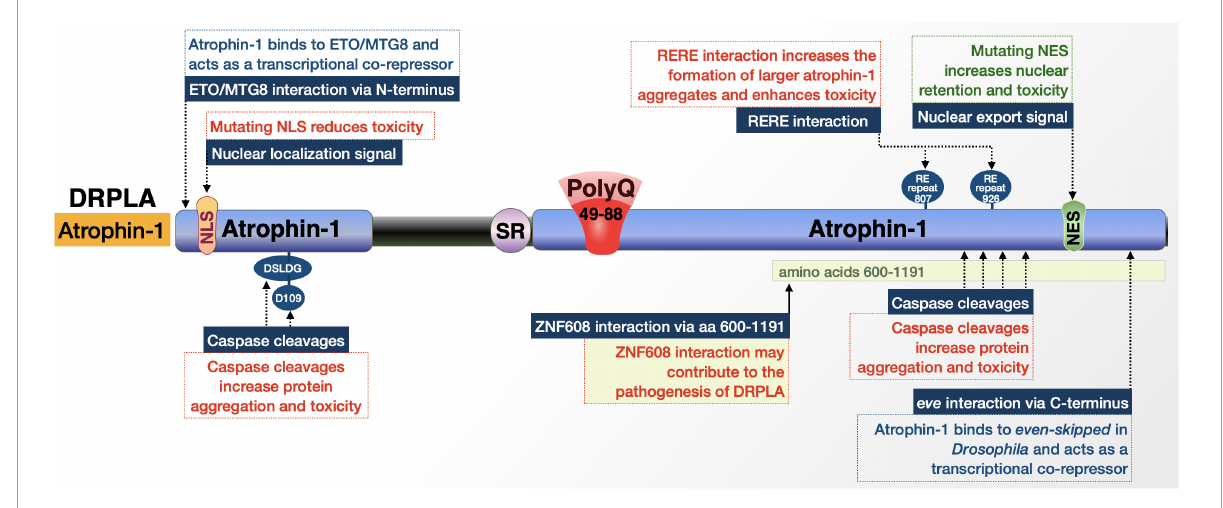
FIGURE2 Graphic representation of the DRPLA protein, its domains, interactions, and modifications. Details are in the main